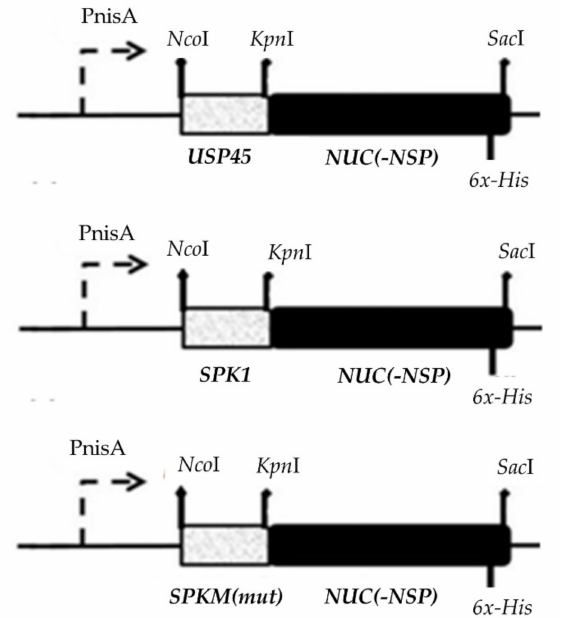
Figure 6. Construction of secretory plasmids harbouring different SP-NUC cassettes. The secretory cassettes of different control SPs (SPK1/USP45) and different SPK1 variants (termed SPKM) fused to the NUC gene were placed downstream of the nisin inducible promoter (P nisA ) of pNZ8048. The respective REs ( Nco I, Sac I, and Kpn I) used for cloning of the genes and a six-histidine (6x-His) tagged sequence included at the C-terminal end of the NUC gene upstream of a stop codon for detection of the target protein are